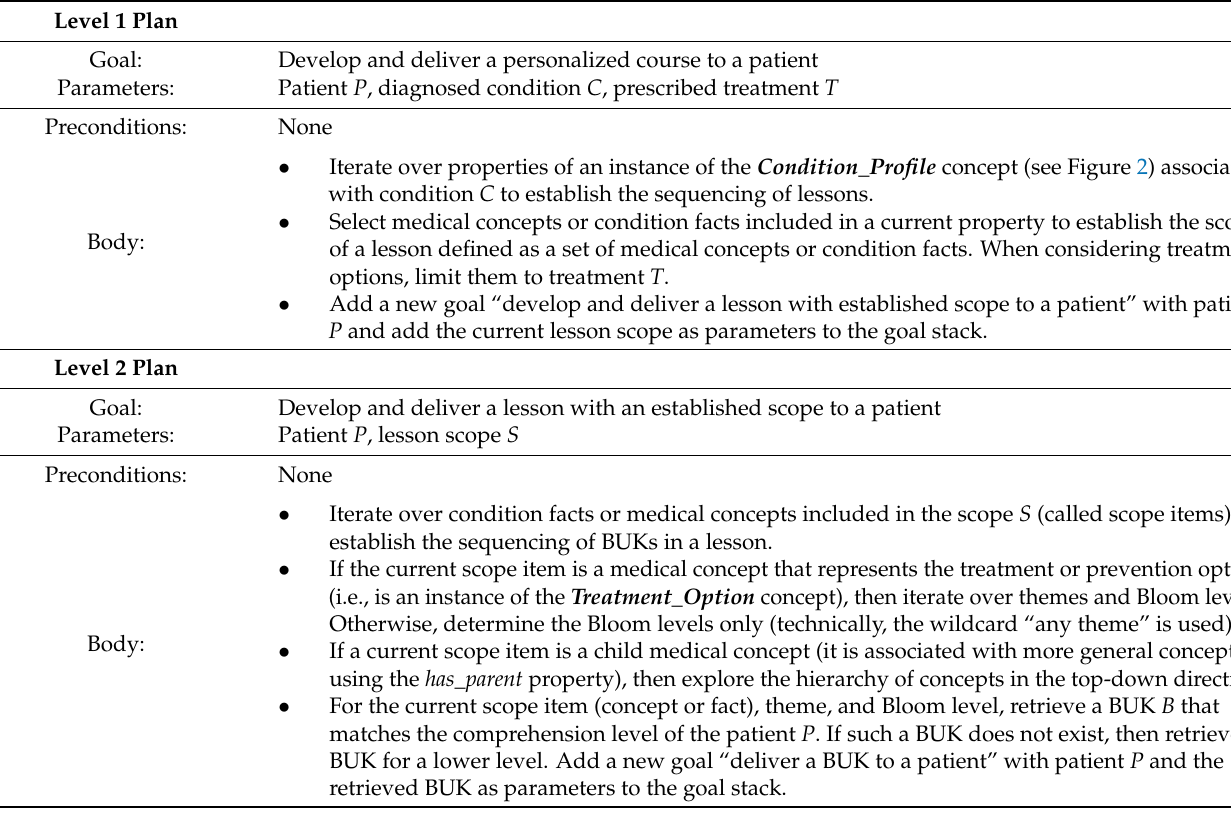
Table 1. Precompiled plans used in the